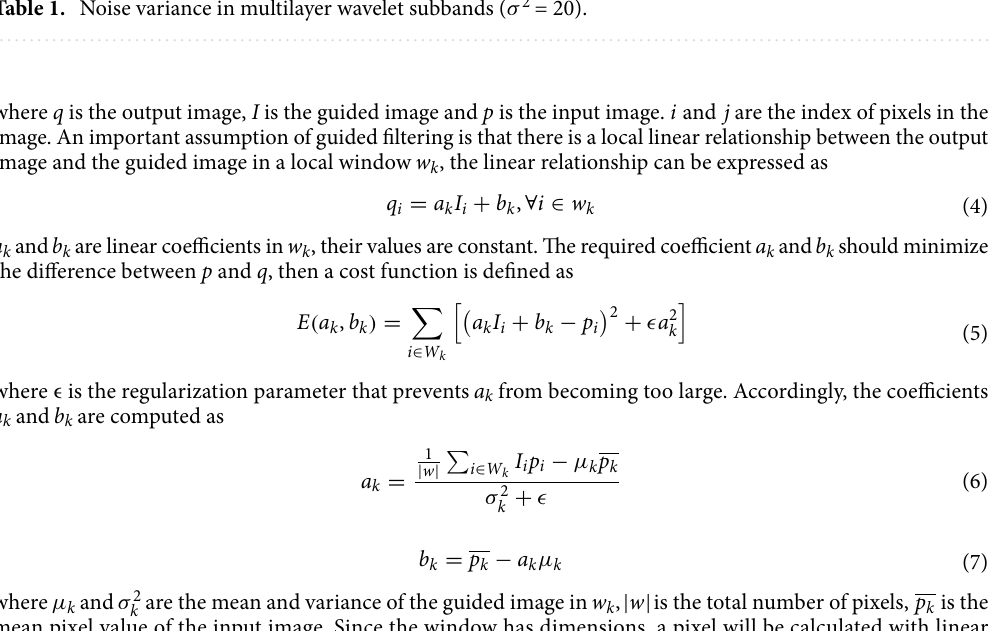
Table 1. Noise variance in multilayer wavelet subbands ( σ 2 =